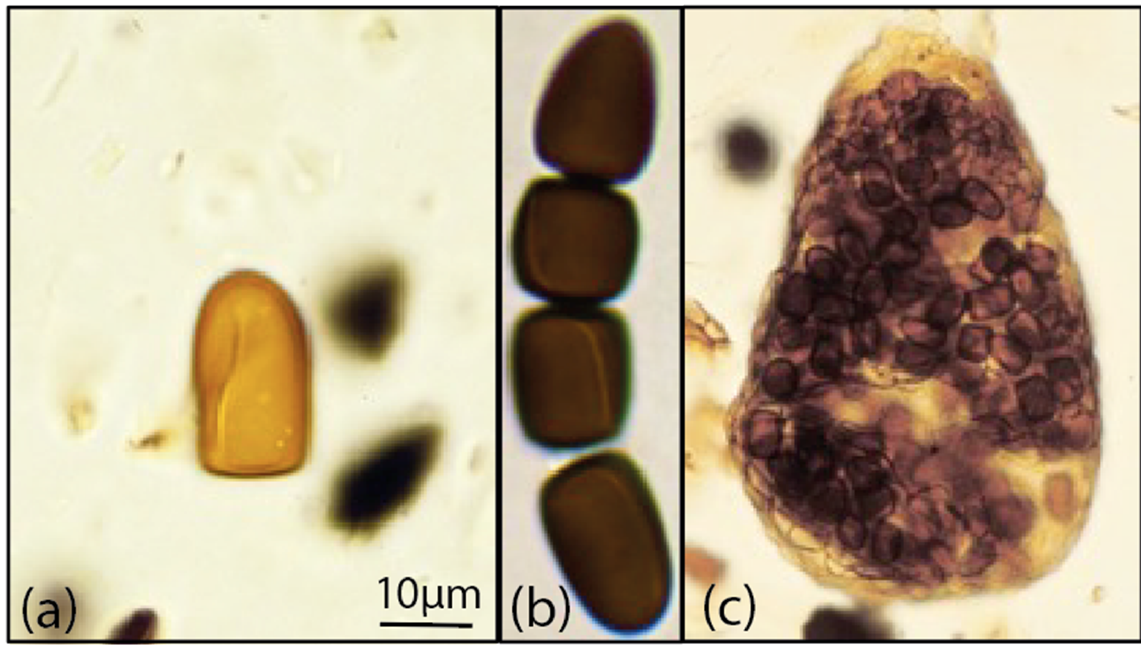
Figure 7. Microscope images of: ( a ) Sporormiella separate cell of ascospore. ( b ) Sporormiella ascospore, and ( c ) Sporormiella fruit body holding ascospore cells.